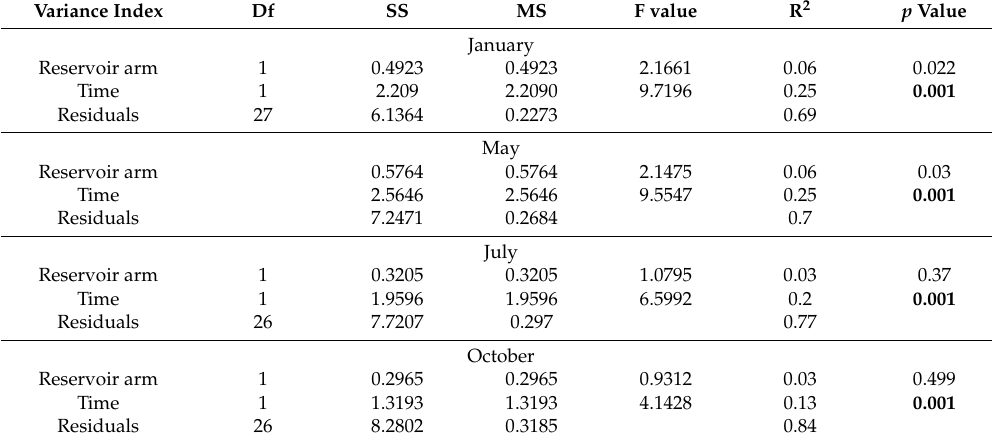
Table A2. Results of permutational multivariate analysis of variance (PERMANOVA) of phytoplankton assemblages for each sampling month. The bold p -values are statistically significant after Bonferroni